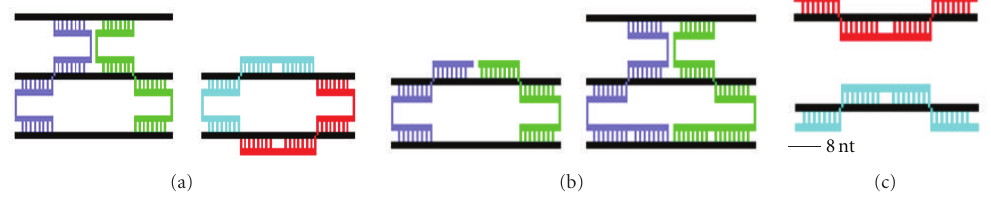
Figure 4: Staple DNA types. (a) general and special type staples, left: Z staple (violet) and S staple (green); right: L staple (blue) and R staple (red); (b and c), variations on the staples when located on the top and bottom edges: (b) S (violet) and Z (green) type staple variations when meeting the top of a seam (left) and the bottom of a seam (right); (c) L (red) and R (blue) type staple variations on the top edge (top) and the bottom edge